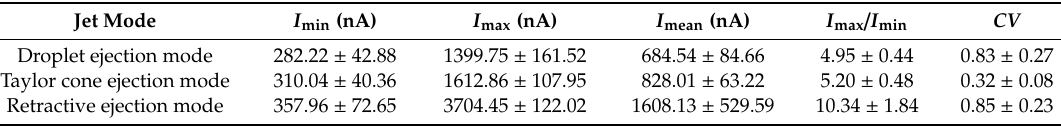
Table 1. Current characteristics in di ff erent jet